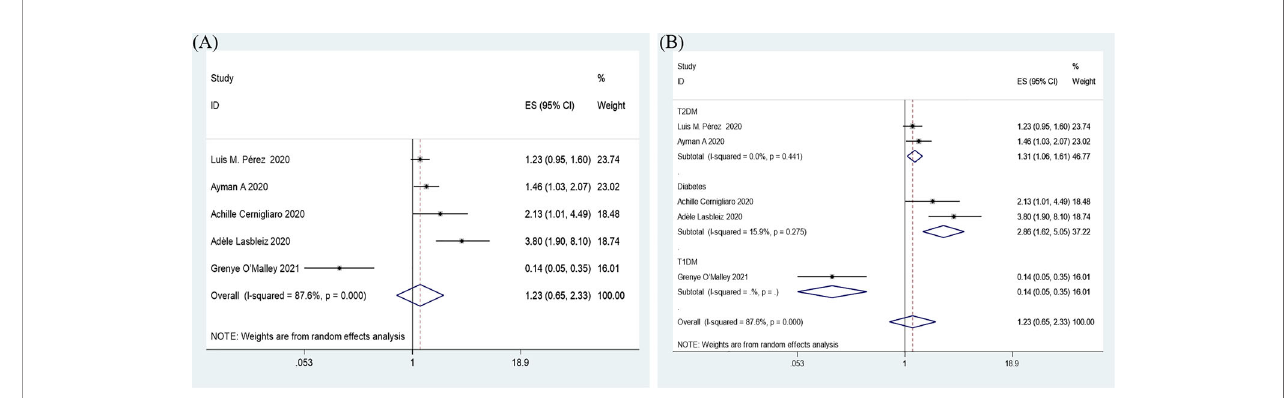
FIGURE 6 | Forest plots of OR for the overall result (A) and subgroup analysis based on type of diabetes (B) of the association between the insulin treatment and the in-hospital admission of COVID-19.